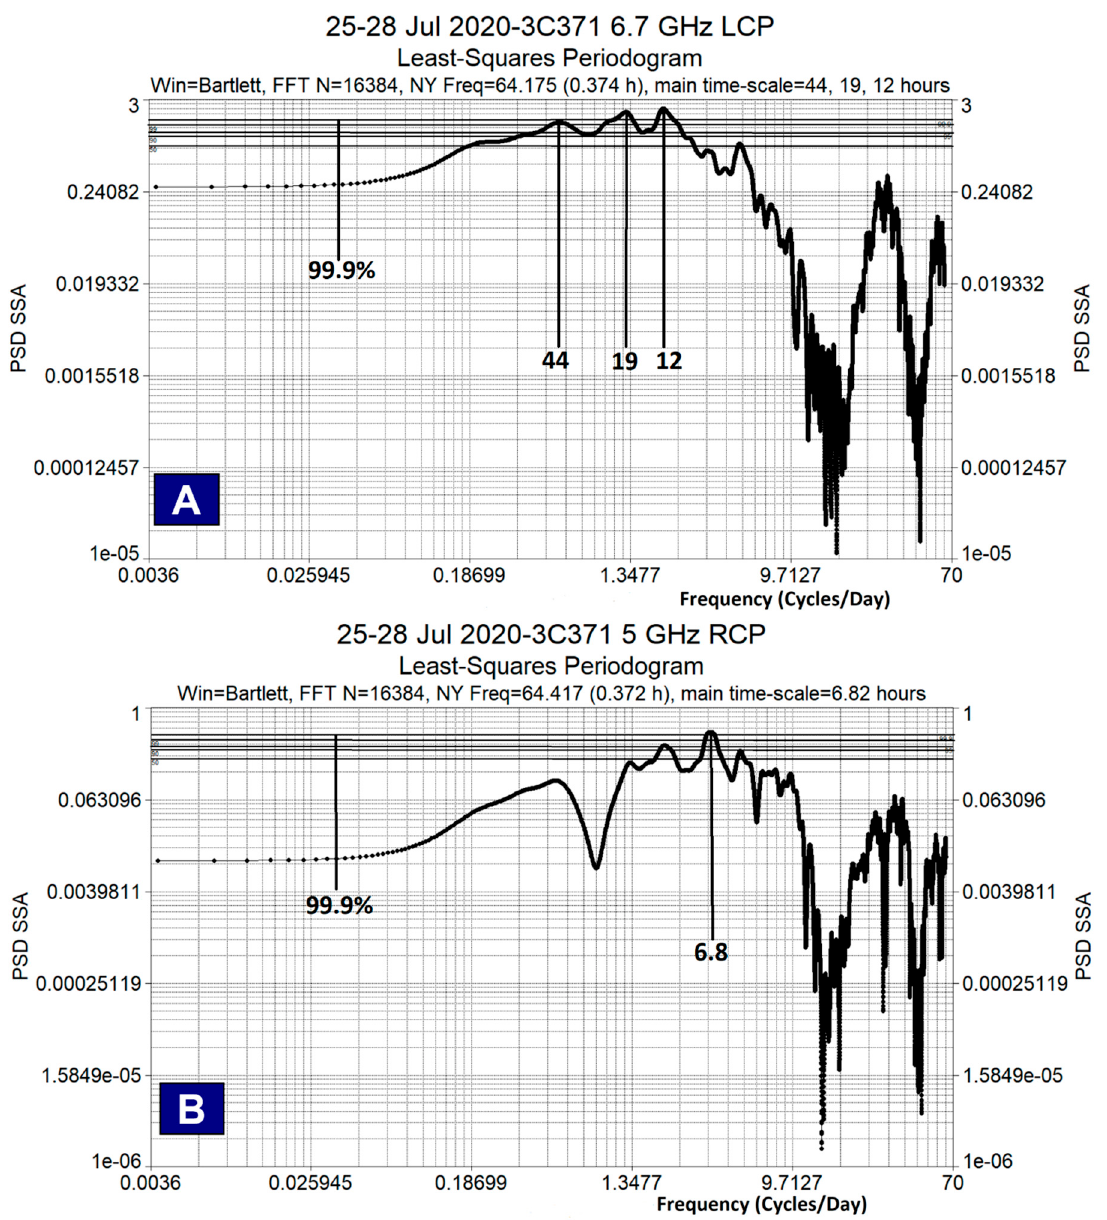
Figure 7. Examples of periodograms for the observation session of 3C 371 source, 25–28 July 2020. ( A ) shows the periodogram (spectrum length 16384, Nyquist frequency 64.175 cycles/day, which corresponds to a period 0.374 h) for left circular polarization at 6.7 GHz (typical variation times are approximately 44, 19, 12 h). ( B ) shows the periodogram (spectrum length 16384, Nyquist frequency 64.417 cycles/day corresponding to a period 0.372 h) for right-hand circular polarization at 5 GHz (characteristic time 6.82 h).